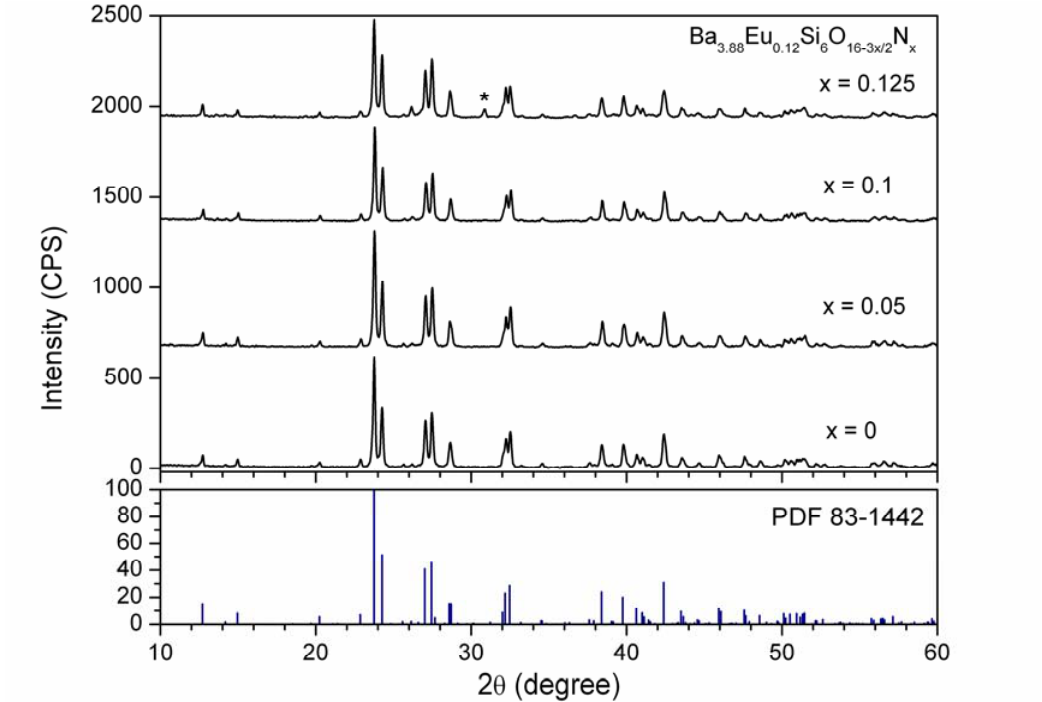
Eu Si O N (x = 0 – 0.125) along with a 3.88 0.12 6 16-3x/2 x Si O . 4 6 16